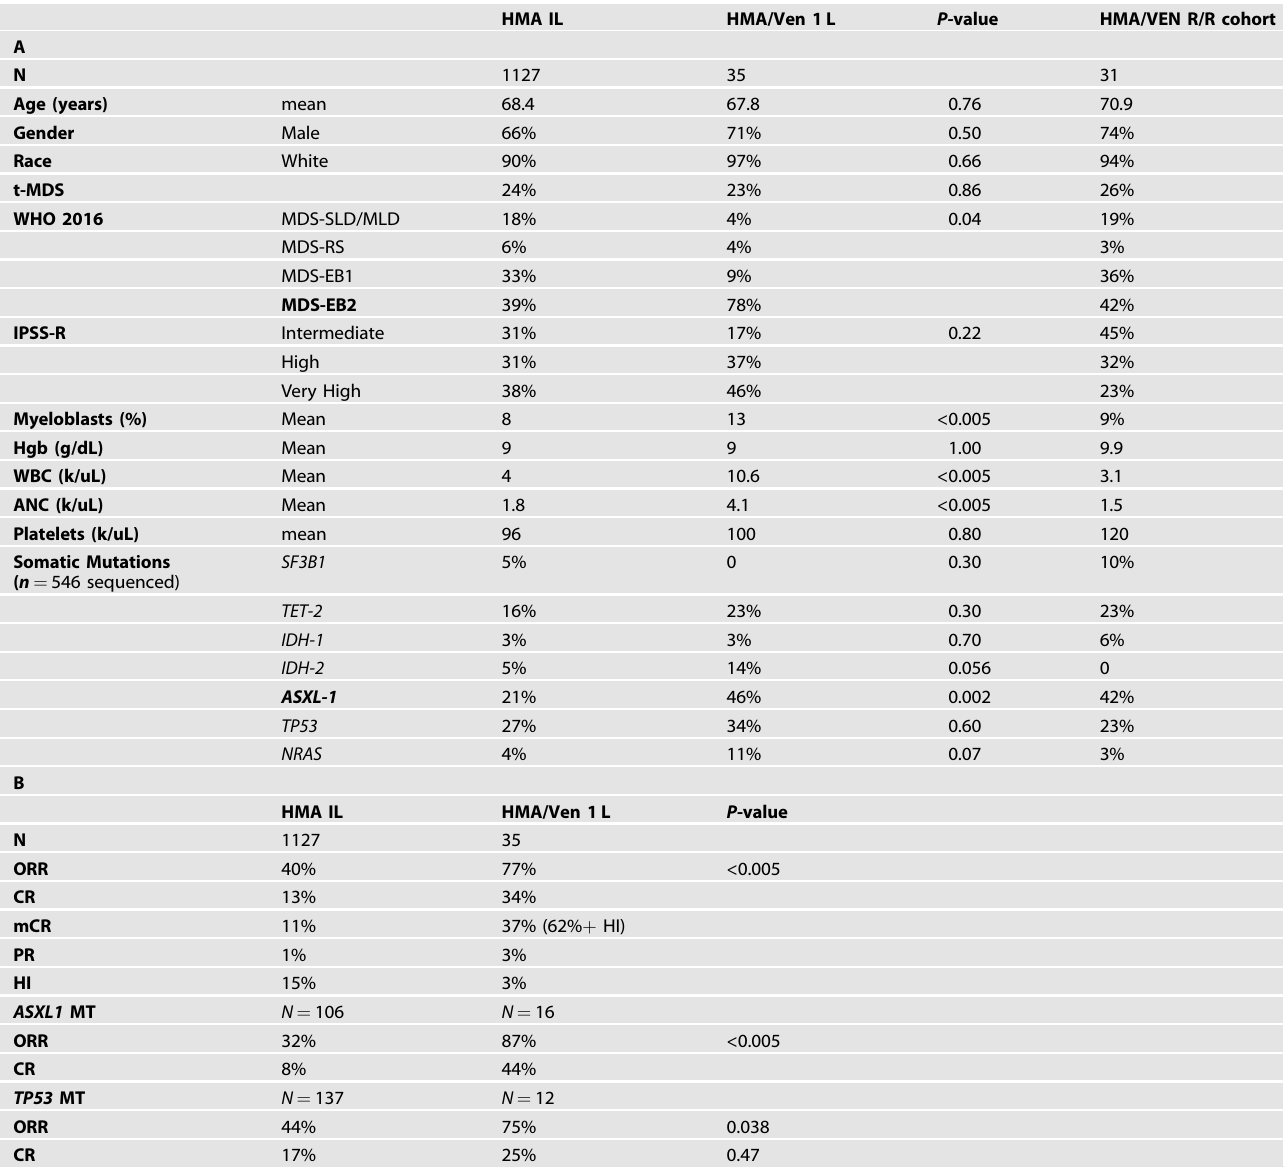
Table 1. A Baseline patient characteristics. B Best response rates to fi rst-line